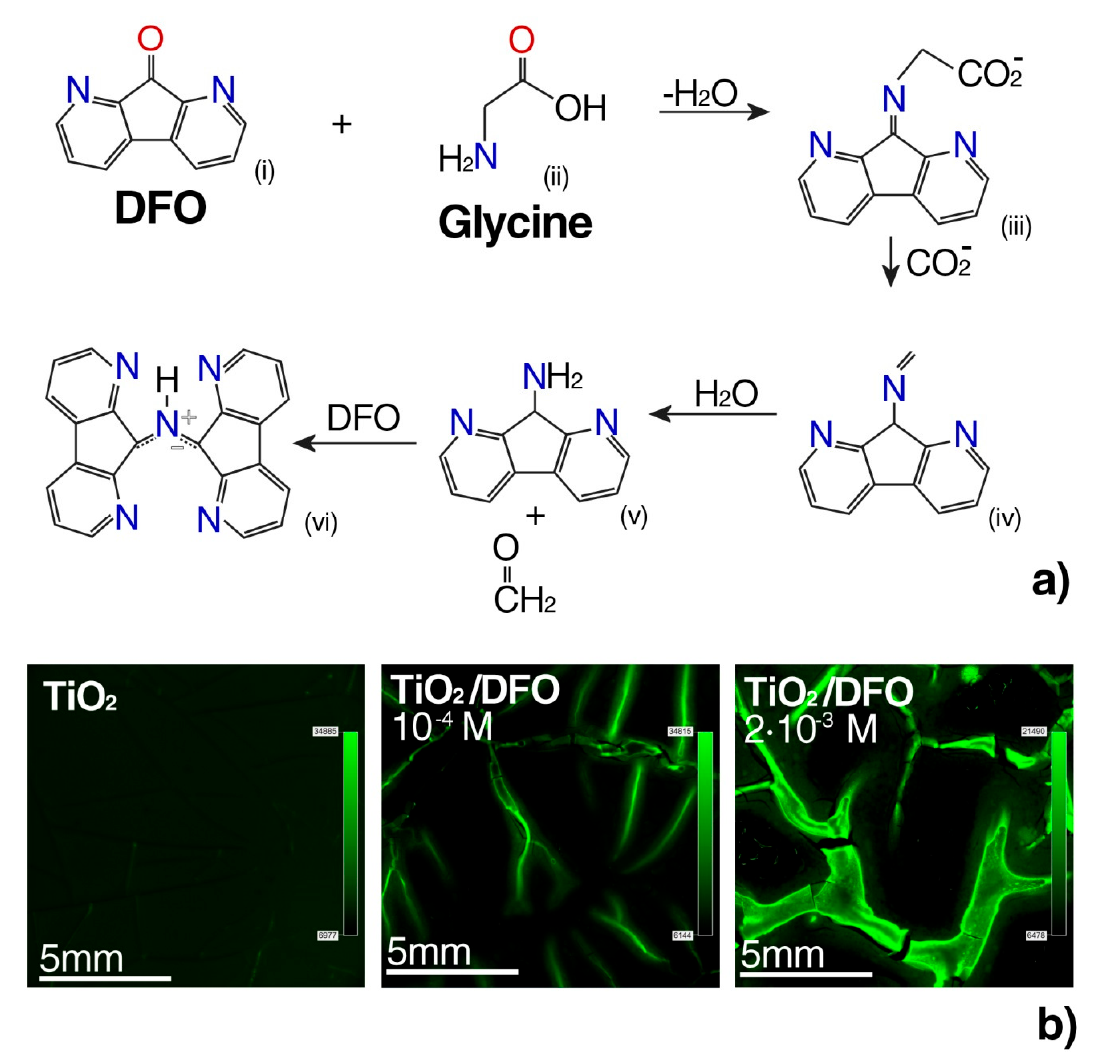
Figure 4. ( a ) Reaction of DFO with α -amino acids: The hemiketal attack from the nitrogen of amino acid at the electron-deficient carbon; after the loss of water, the imine is formed, which maintains the alkyl fragment from the amino acid and decarboxylation to form (IV). Hydrolysis shows at the nitrogen-carbon double bond formatting of an aromatic amine (V) and acetaldehyde and reacts with another DFO molecule to create 9-(1,8-diazafluoren-9-ylidene)amino-1,8-diazafluorenone (VI) [40]. ( b ) Fluorescence micrograph of DFO in TiO 2 thin films at different DFO concentrations after reacting with glycine, with λ exc = 450 nm.